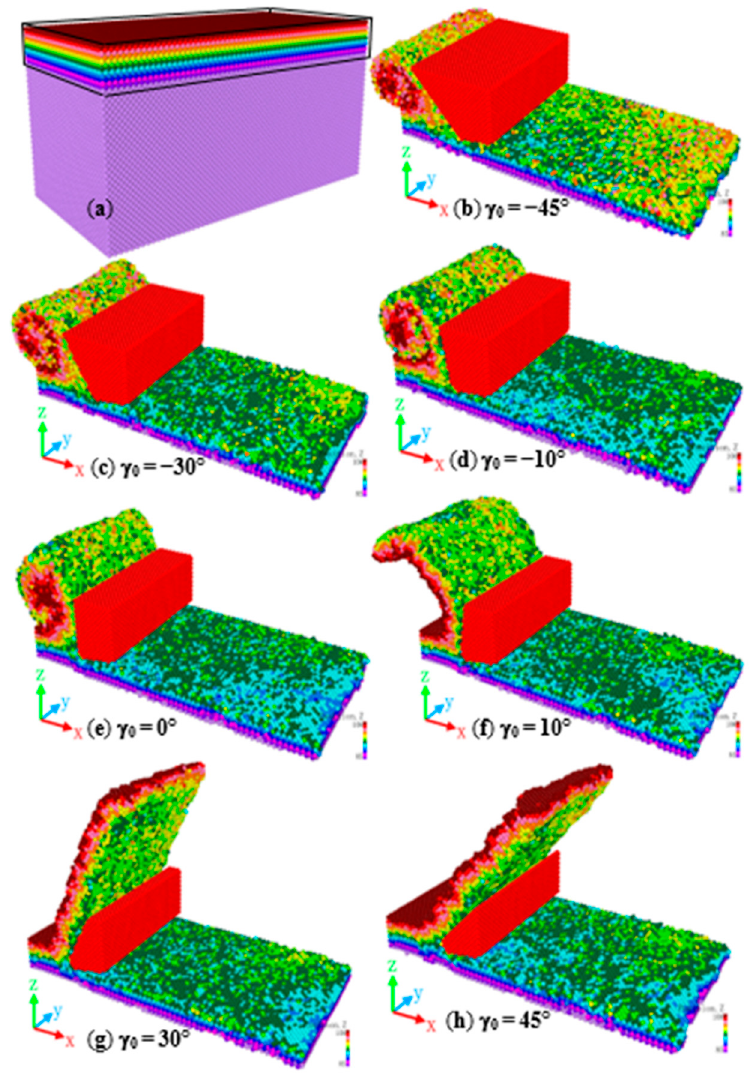
Figure 3. Chip morphology of monocrystalline nickel processed by different tool rake angles. Set straight line as Substituting Formula (3) into Formula (2), we get